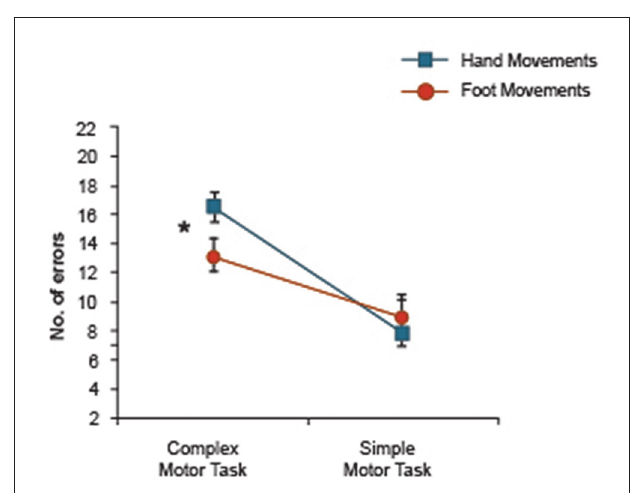
FIGURE 4 | Motor Movement × Task Complexity interaction of arm-related words only in both experiments showing a significant Motor Movement difference in the complex motor task. ∗ Indicates